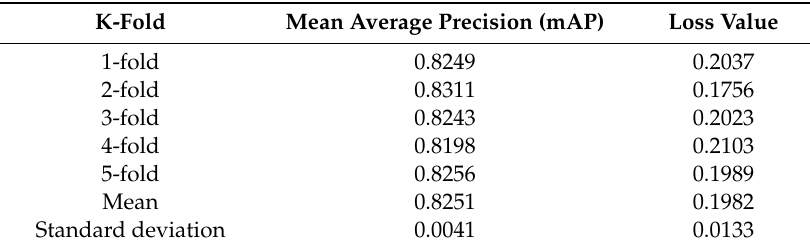
Table 2. Five-fold cross-validation